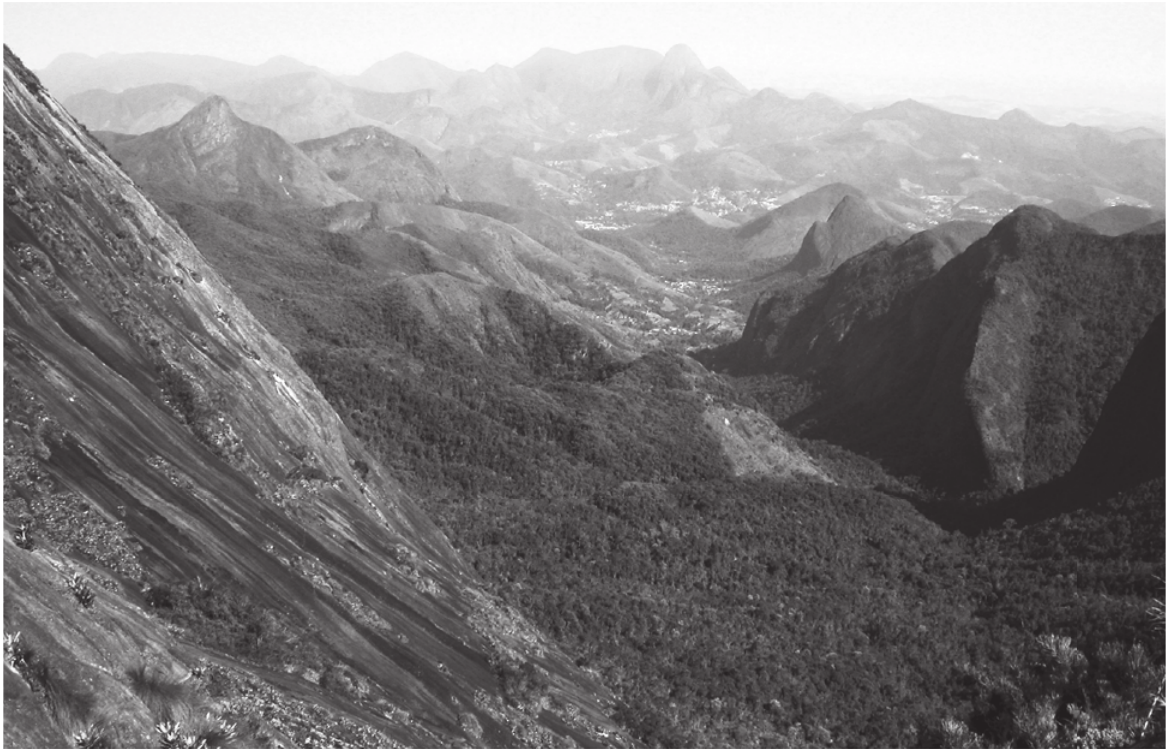
Figure 1 - Exposed granite outcrops and Atlantic Forest in the Serra dos Órgãos (in the background: city of